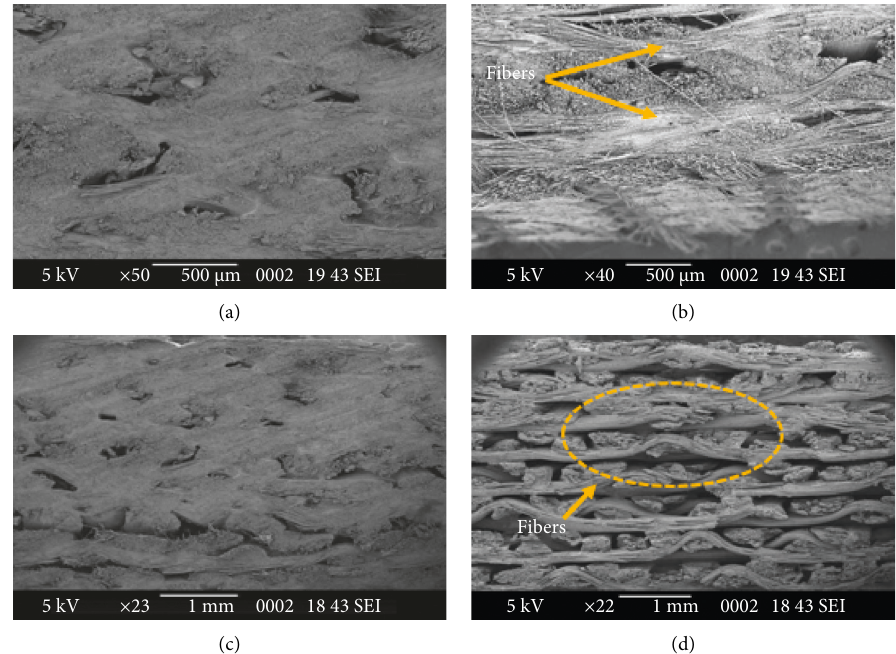
Figure 12: SEM images of (a) unburnt and (b) burnt C-Ph samples after exposing to oxyacetylene flame and (c, d) the same at higher